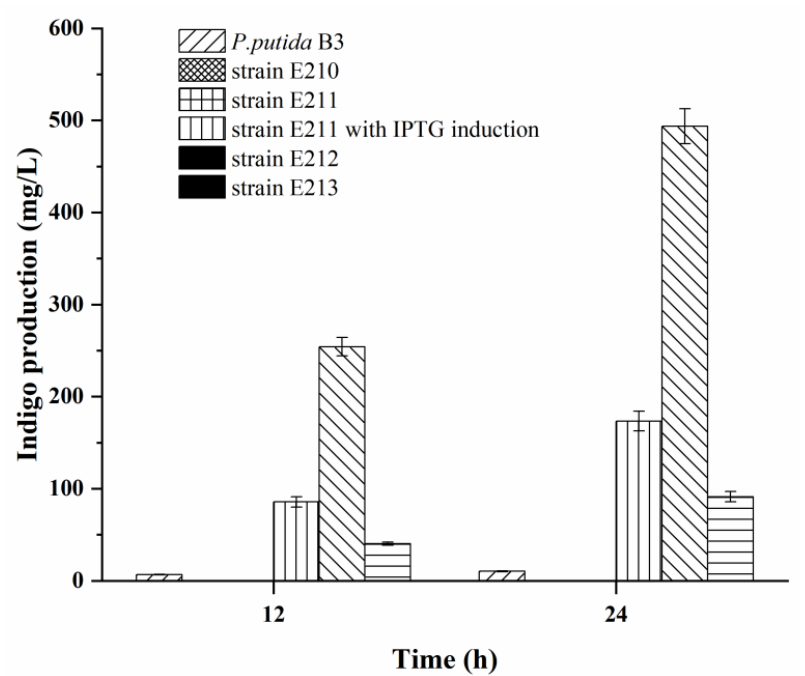
Figure 1. Indigo production from tryptophan at the 2.0 g/L concentration in fermentation of Psedumononas putida B3, E211, E212 and E213 after 12 h and 24 h.